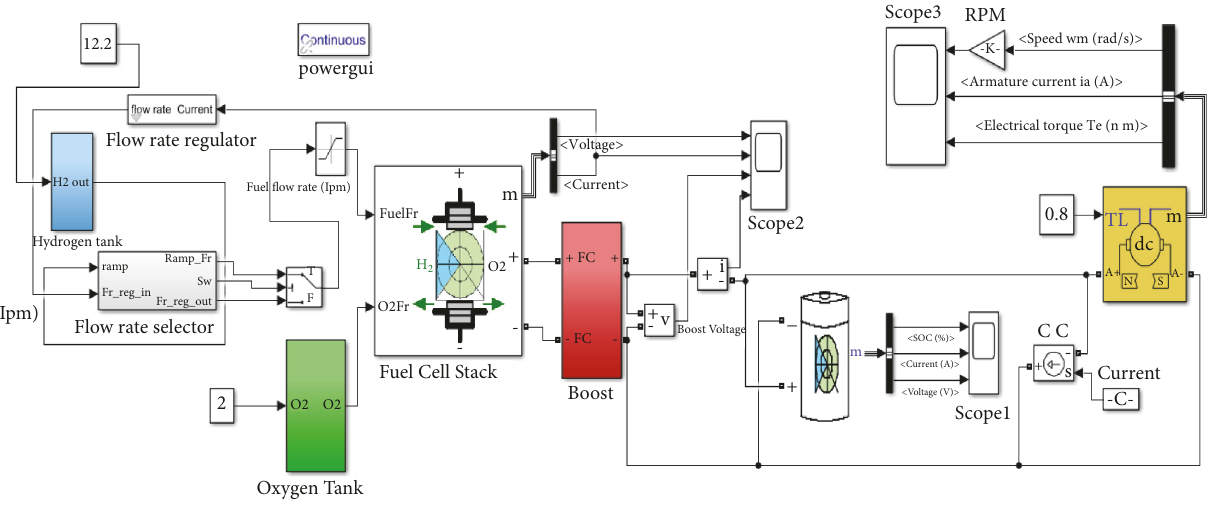
Figure 15: Dynamic model in MATLAB/Simulink Software.